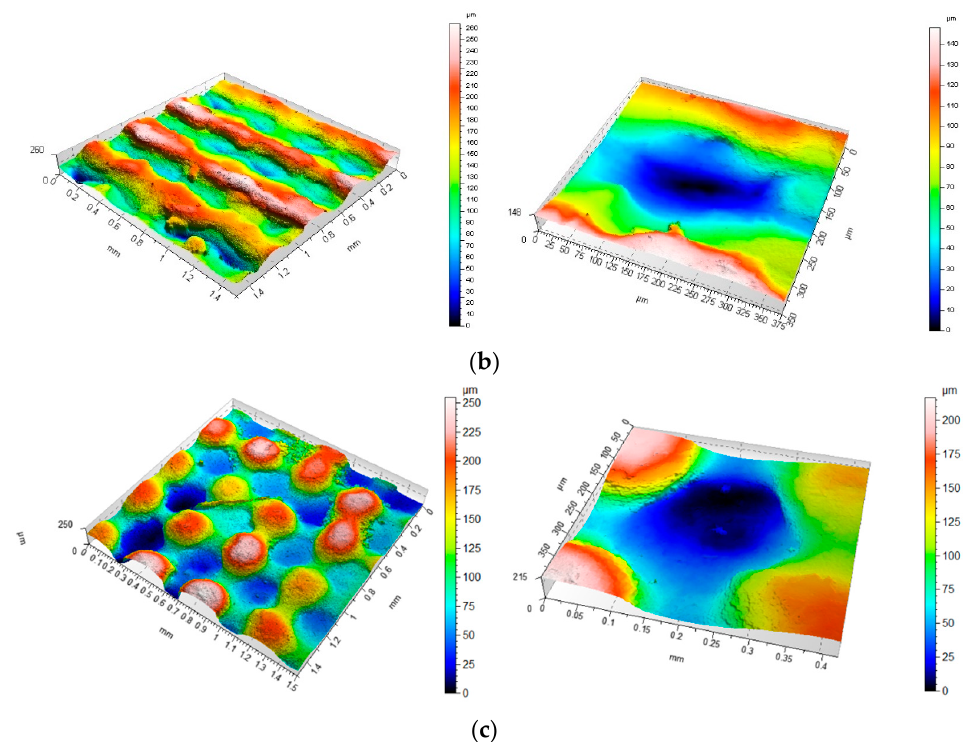
Figure 6. An example isometric view of the surface of sample 5 together with a view of an example dimple at an angle of ( a ) 0° ( b ) 45° ( c ) 90°; scales should be analysed carefully.